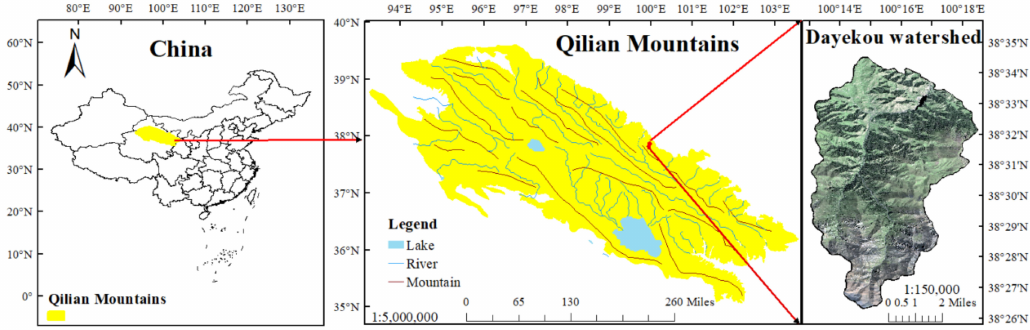
Figure 1. Location of Dayekou watershed in the Qilian Mountains of northwestern